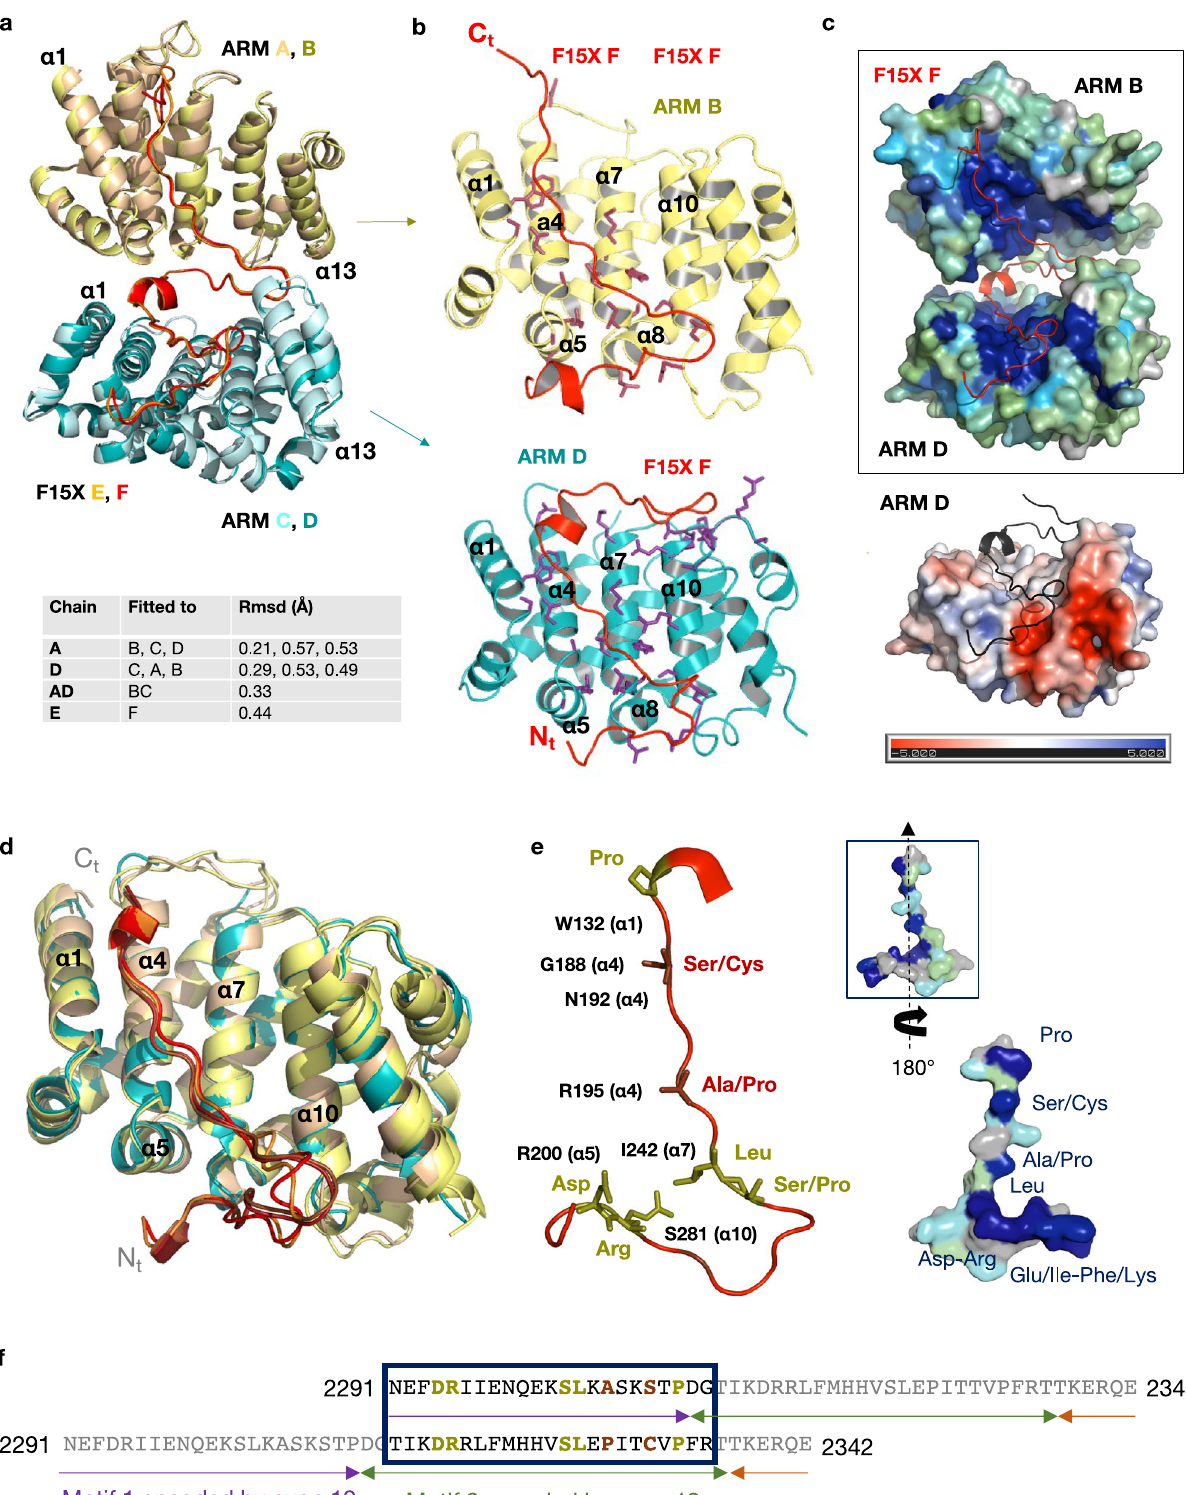
high-af fi nity interaction between BRCA2 and HSF2BP and of the resulting HSF2BP oligomerization. To study this in the context of meiotic HR, we created a Brca2 Δ 12/ Δ 12 mouse model (Fig. 6a – c). Consistent with the robust proliferation of the engineered BRCA2 Δ 12 HeLa and mES cells, Brca2 Δ 12/ Δ 12 mice were viable, born at Mendelian ratios, and did not show any overt phenotypes. Contrary to our expectation, the Δ 12 mutation did not phenocopy the Hsf2bp